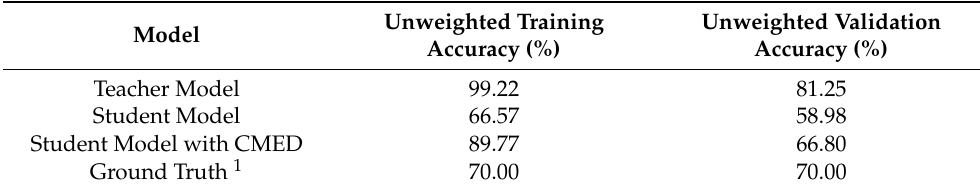
Table 4. Results of the experiments with cross-modal emotion